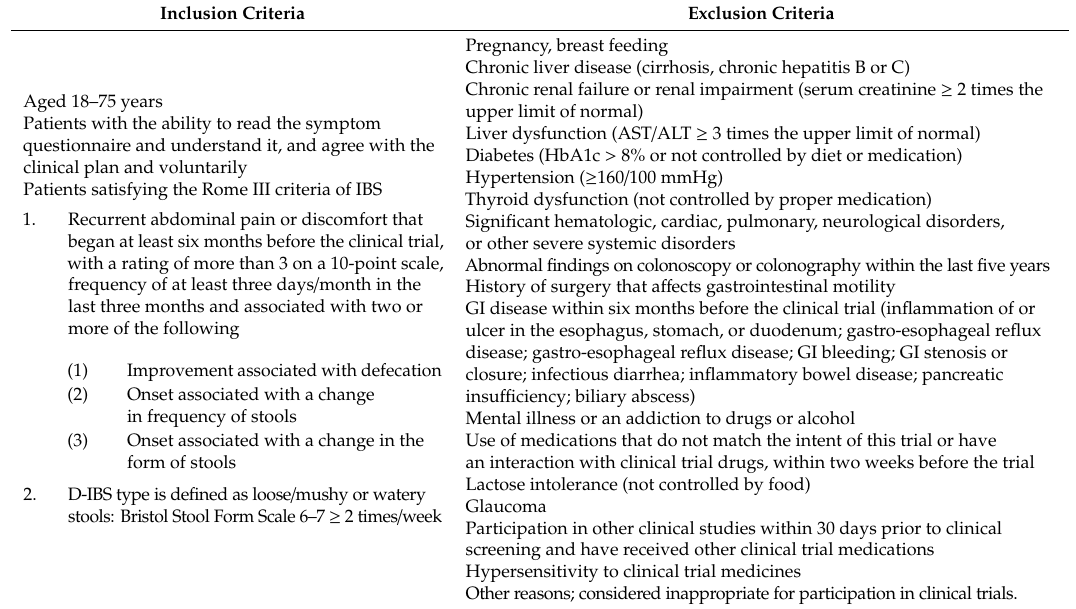
Table 1. Inclusion and exclusion